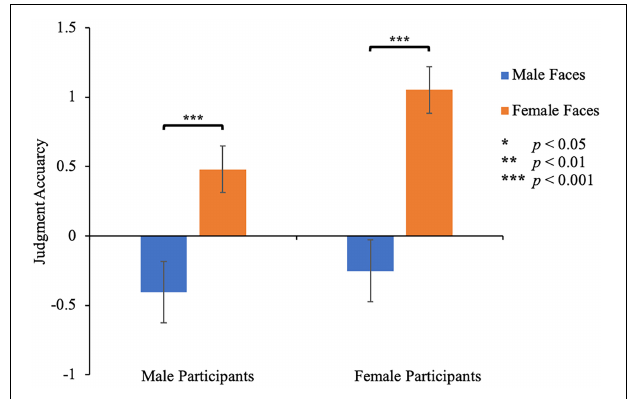
FIGURE 4 | Rating accuracy of wealth in Study 3. Error bars represent 1 S.E. of the means.